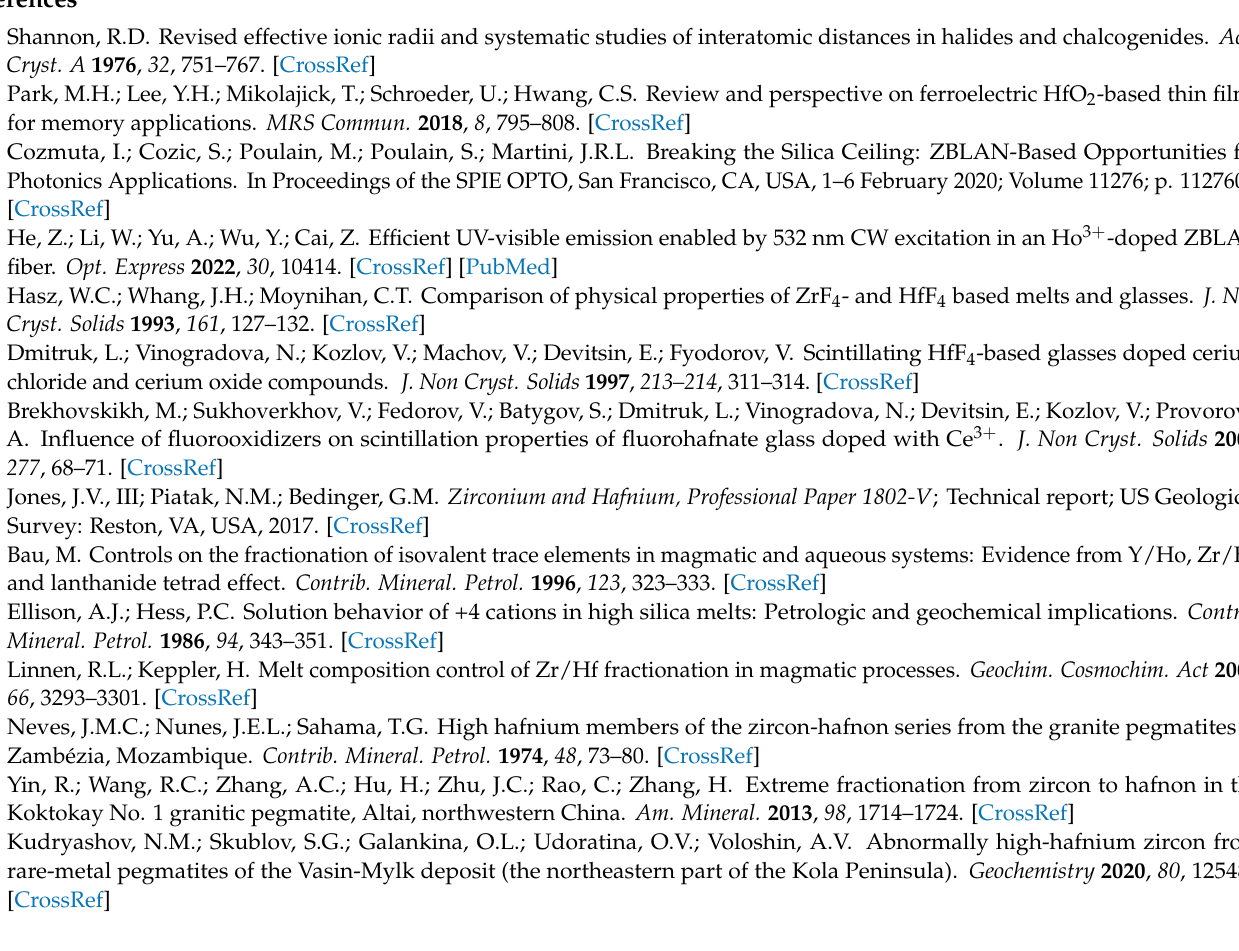
functional. Table S8: Comparison of M–F bond length in Å and ZPE in meV per formula unit for molecular ZrF 4 and HfF 4 with or without ZORA. References [25,27–48,68–73,77,78,86–94] are cited in the supplementary